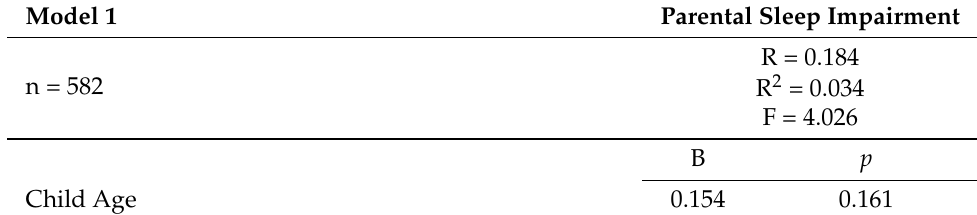
Table 5. Moderated Multiple Regression Analysis.